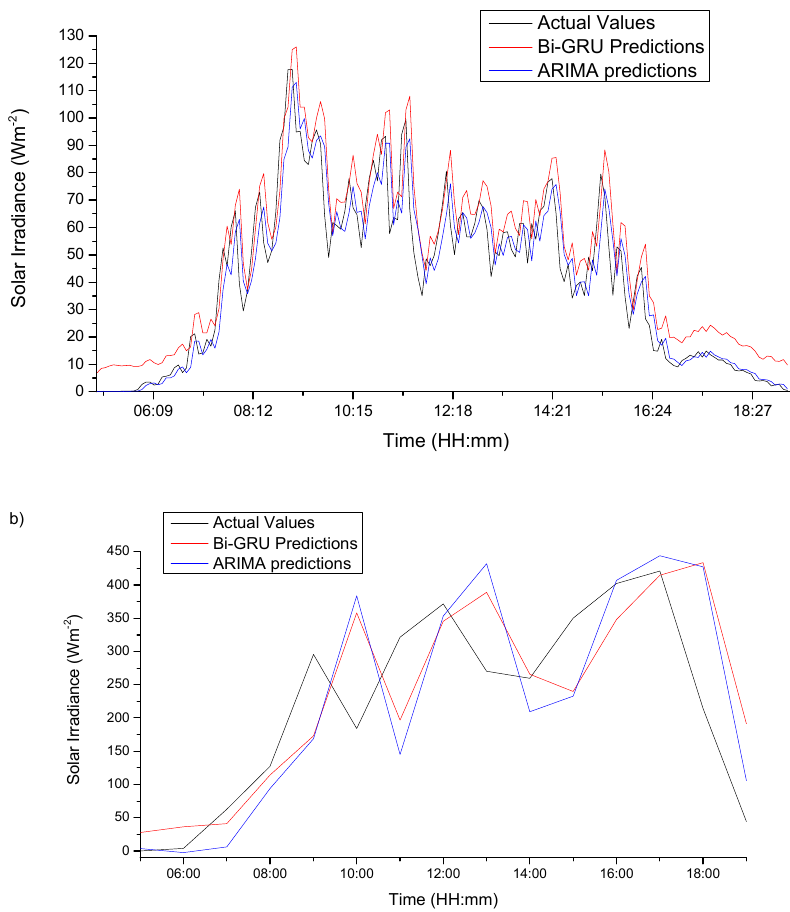
Figure 5. ARIMA and Bi-GRU models’ forecast comparison with the actual solar irradiance values ( a ) 5-min short interval ( b ) 60-min very short interval.